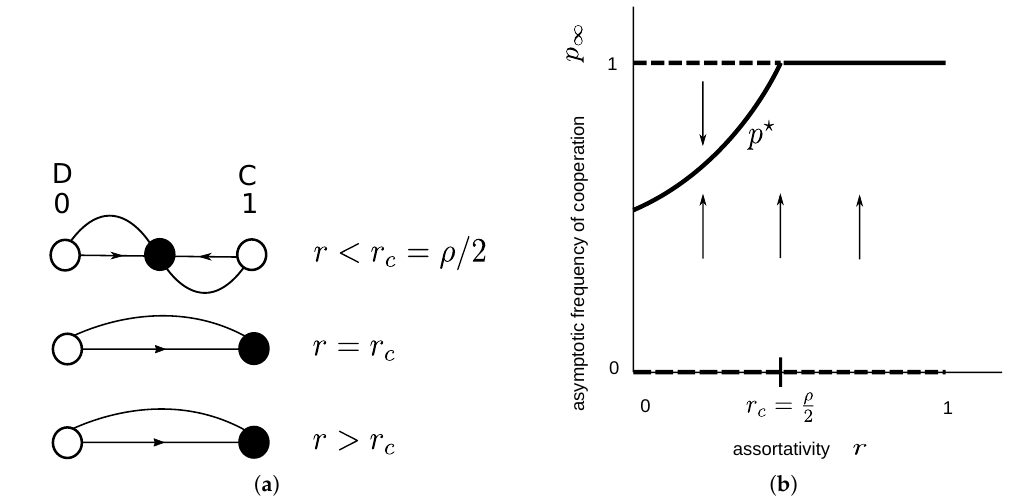
Figure 2. Phase line diagrams and the bifurcation diagram for the snowdrift game with assortative interactions. ( a ) In the phase line diagrams closed circles represent stable equilibrium points, open circles represent unstable equilibrium points, and the curved line connecting equilibrium points indicates the graph of the function on the right-hand side of the r -replicator equation. ( b ) In the bifurcation diagram solid lines represent stable equilibrium points, dashed lines represent unstable equilibrium points, and arrows indicate the direction of evolutionary